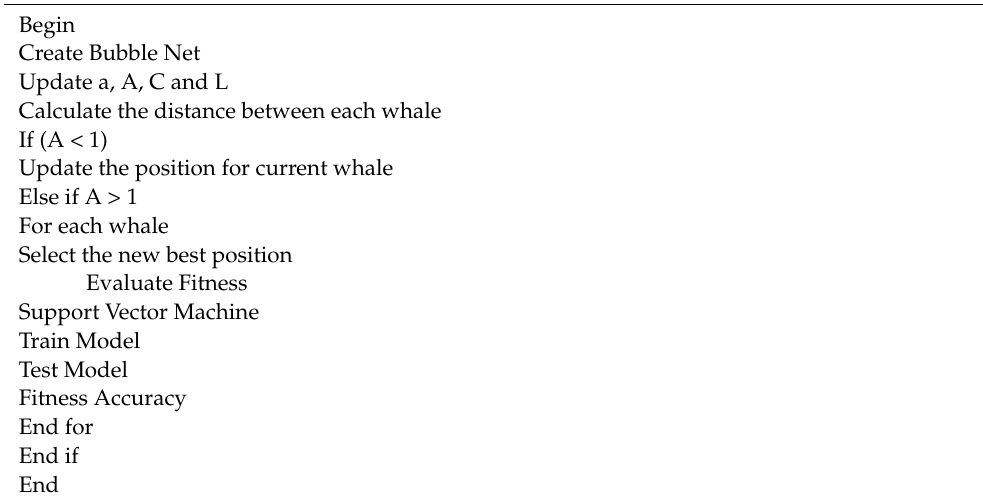
Algorithm 3. The WOA-SVM pseudocode.